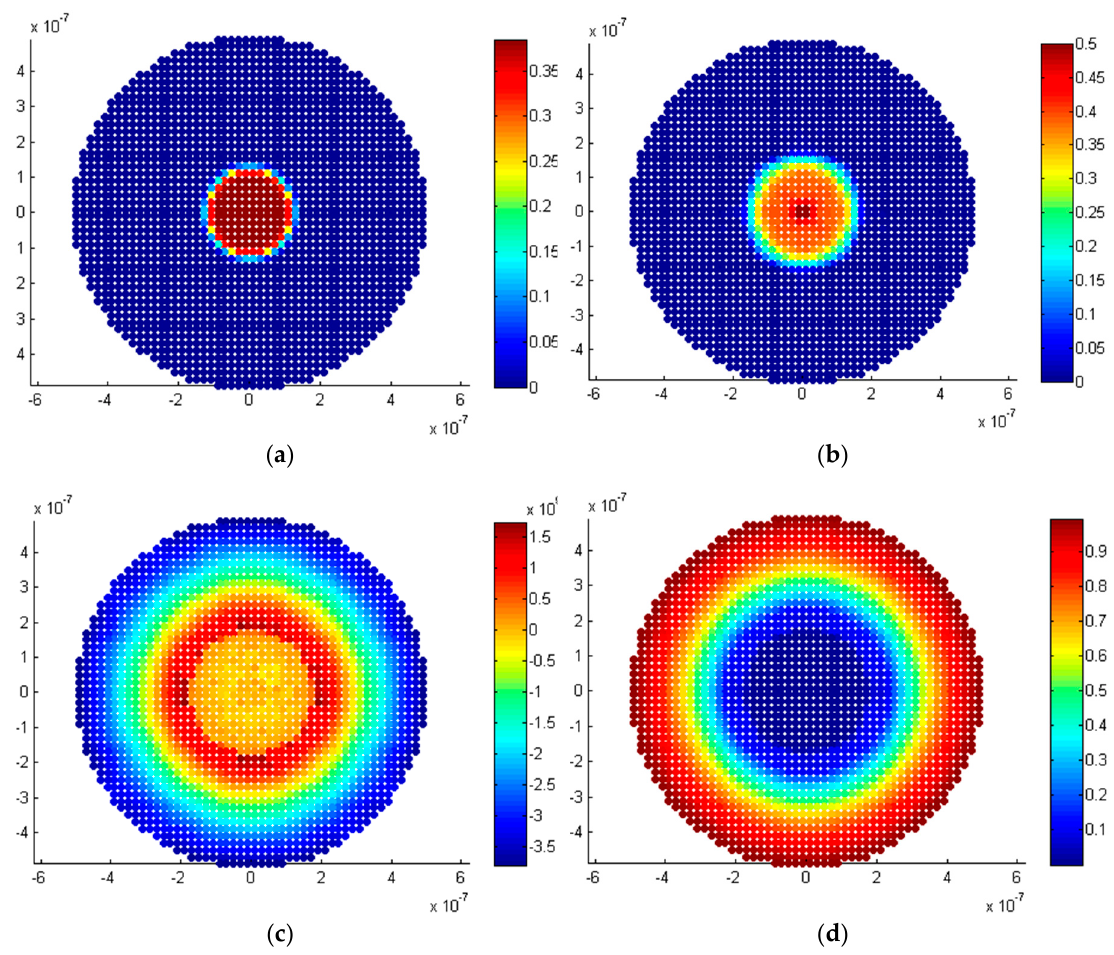
Figure 5. Results for a penny-shaped, cracked anode in the x - y mid-plane (crack surface plane): ( a ) initial damage; ( b ) new damage; ( c ) hydrostatic stress; and ( d ) lithium ion concentration.